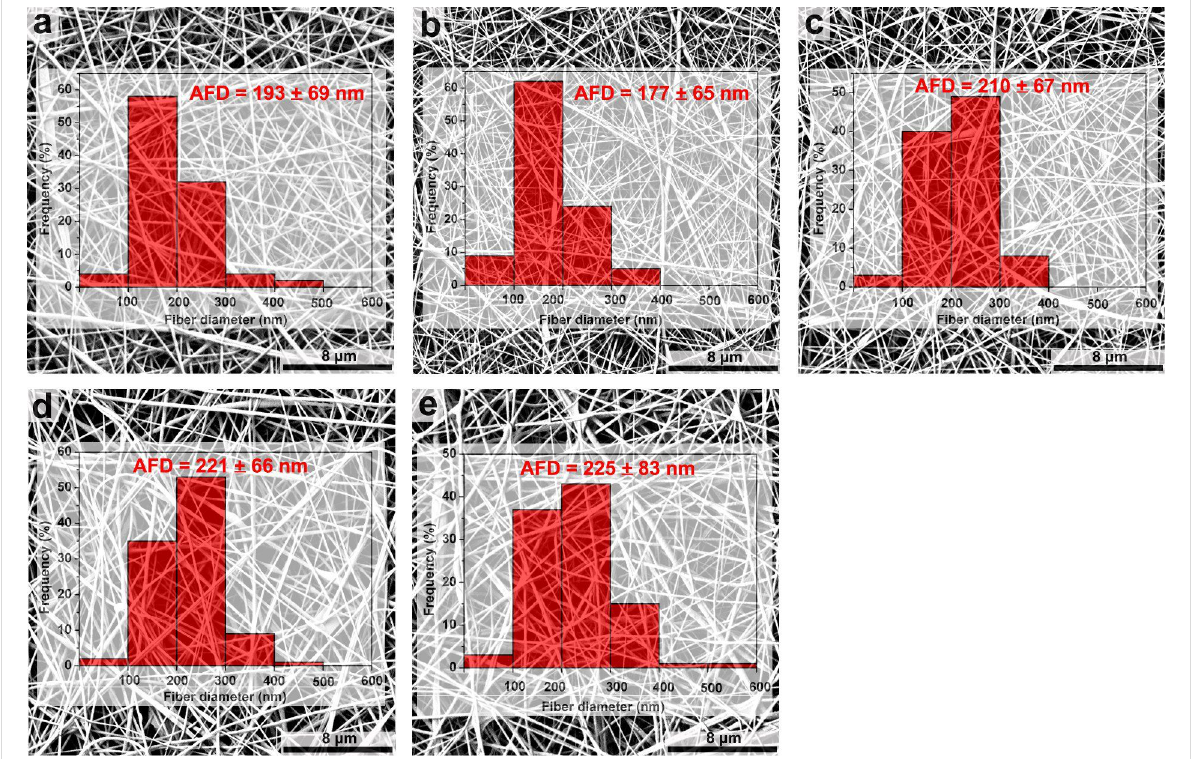
Figure 1: Representative SEM images and the corresponding diameter distribution of the nanofibers: (a) neat PCL; (b) PCL/CB[7] (100:50); (c) PCL/CB[7] (100:100); (d) PCL/CB[7] (100:150); (e) PCL/CB[7] (100:200).